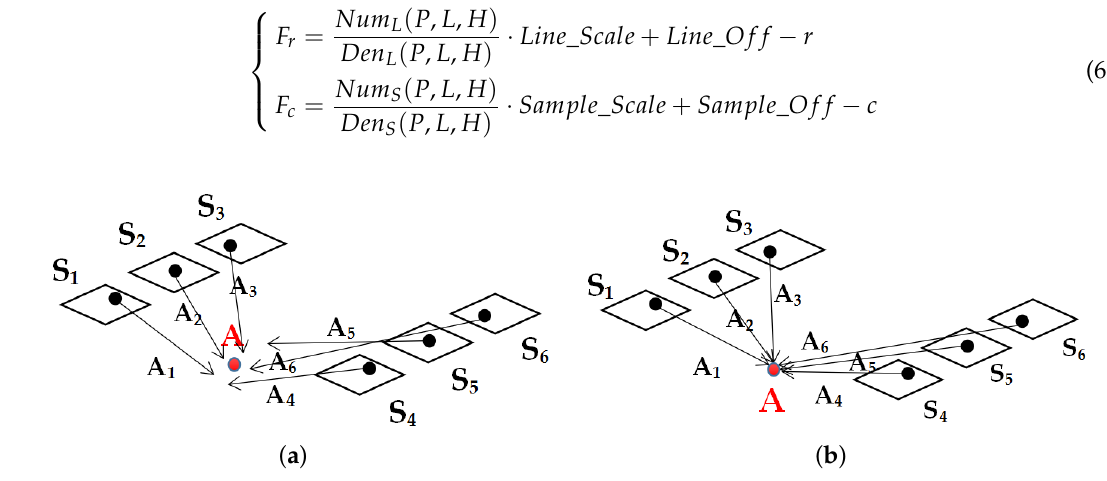
Figure 4. An Example of the space intersection method. S 1 ∼ S 6 are different observations of the same object A (the red points) at different times, and A 1 ∼ A 6 are the calculated corresponding coordinates in object-space with the help of